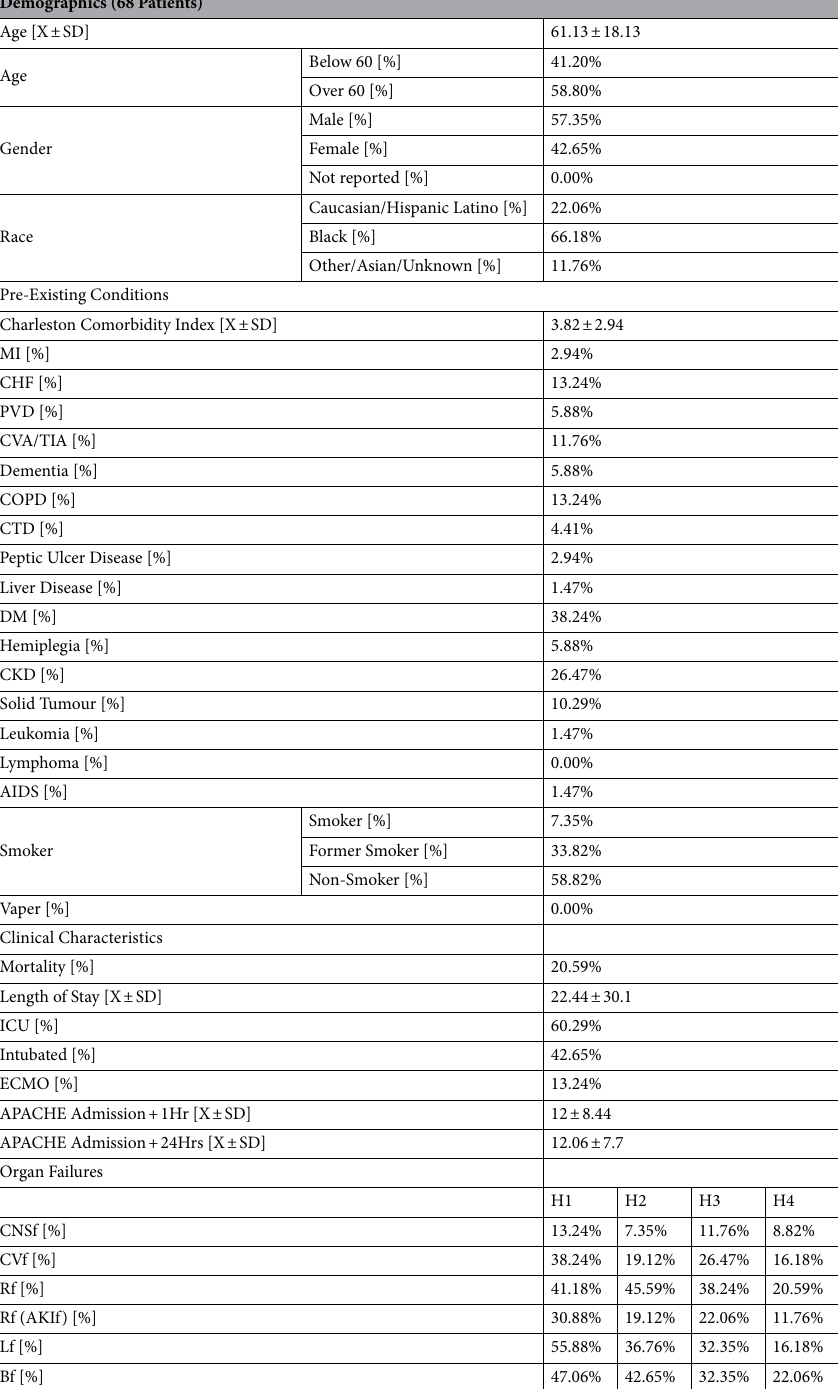
Table 1. Demographical and clinical characteristic of the studied